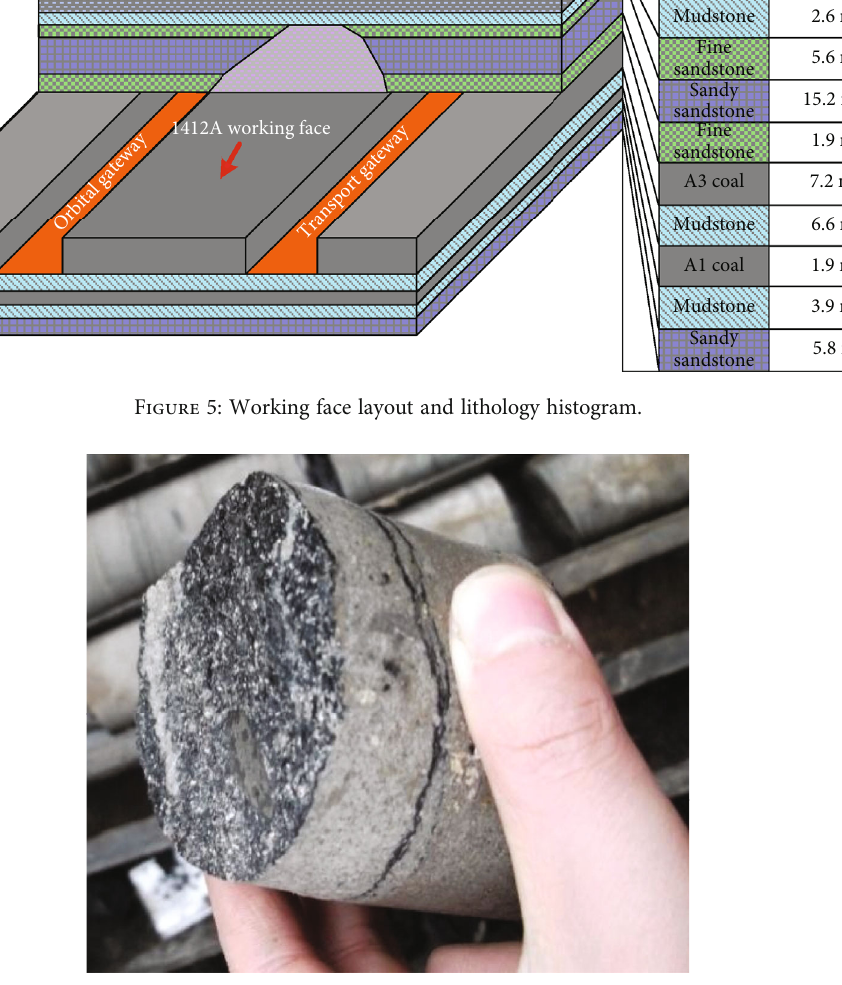
Figure 6: The sandstone intercalated with organic